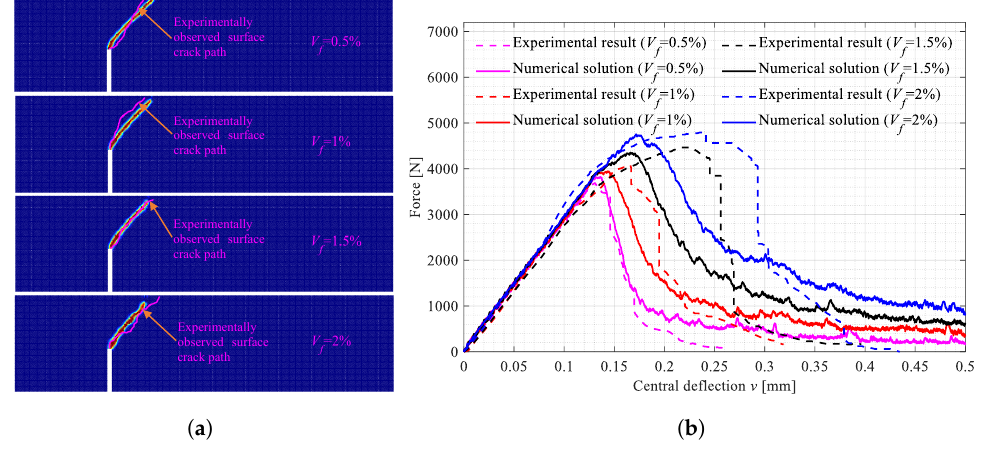
Figure 14. The crack patterns in the beam specimens with C l = 40 mm and the central deflection-force diagrams. ( a ) Surface crack patterns; ( b ) Central deflection-force